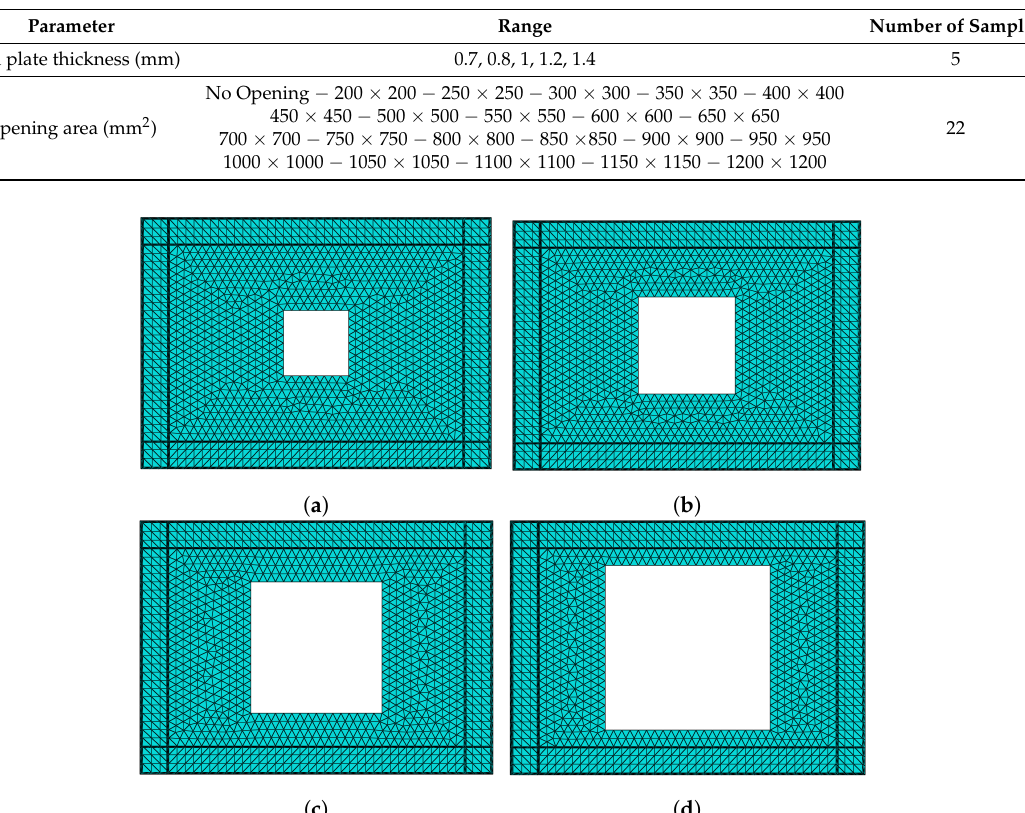
Table 3. The range of the evaluated parameters and the number of FEM samples.